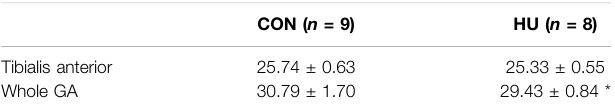
TABLE 2 | T2 values in muscles of HU and CON mice.